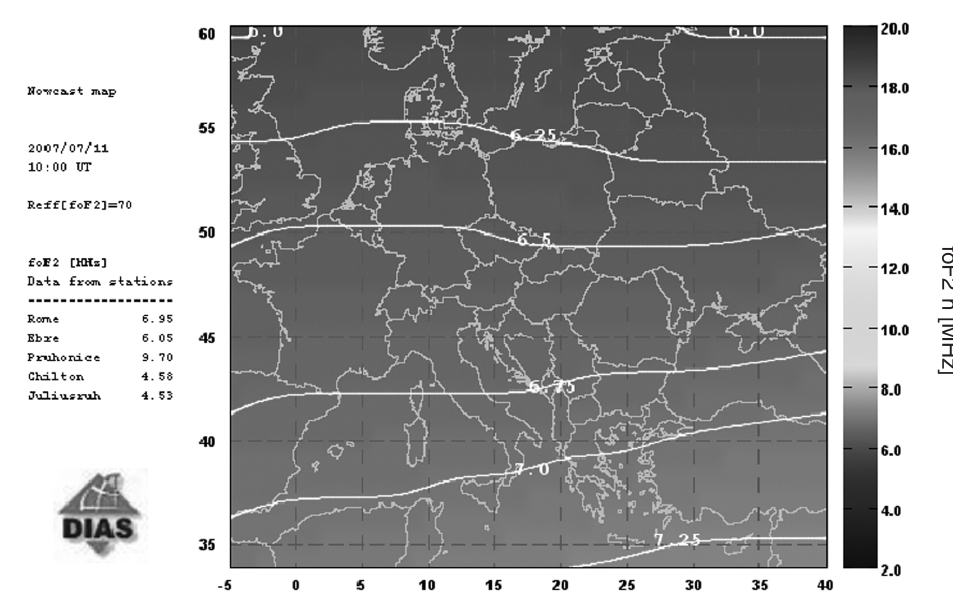
Fig. 8. Map of foF2 produced by SIRMUP and regional R12eff in the DIAS system on 11 July 2007 at 10